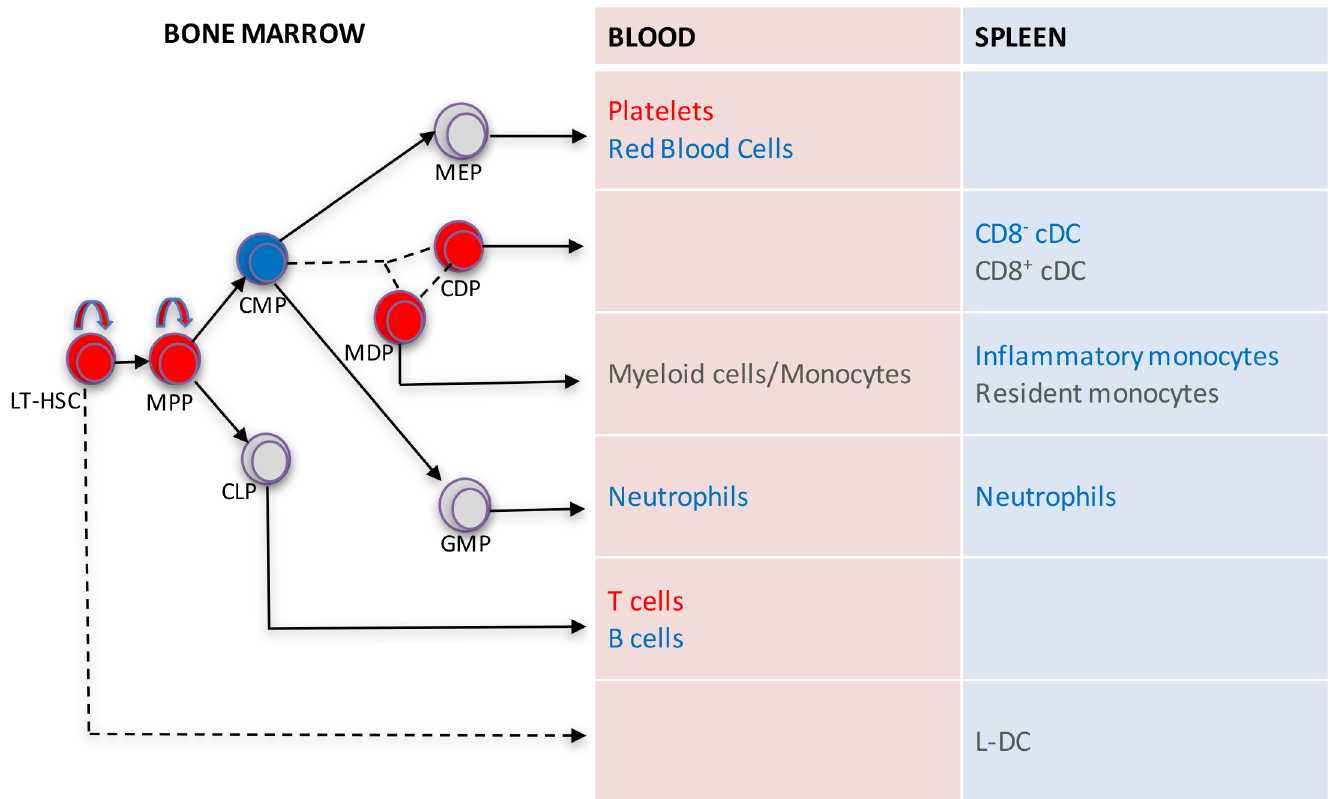
Fig 8. Changes in hematopoiesis attributable to the c-Myb 308G mutation. The summary diagram combinesanalysisof stem/progenitor subsets in mutant mouse bone marrow, with subset analysisof mature cell subsets in blood and spleen of chimeras reconstituted with mutant fetal liver cells and analysedat 16 weeks after reconstitution. Significantchangesin cell production in relationto wild type mice or wild type control chimeras are shown in red indicatingincrease,or blue indicating a decrease, in cell production.Subsets unchanged in mutant and wild type are shown in grey. The diagramis not a completelineagemap since only subsets analysedare shown. These include: LT-HSC, longterm hematopoietic stem cell; MPP, multipotential progenitor; CMP, common myeloidprogenitor; CLP, common lymphoidprogenitor; MDP, myeloid dendriticprogenitor; CDP common dendriticprogenitor; MEP, myeloid/erythroid progenitor; GMP, granulocyte/macrophage progenitor. The lineagerelationshipbetweenthe MDP subset and CMP and CDP is shown as a dashedline since it is still in doubt [45]]. Similarly, the derivationof L-DC directly from bone marrow HSC and MPP is shown as a dashedline, since this has only been confirmed in vitro